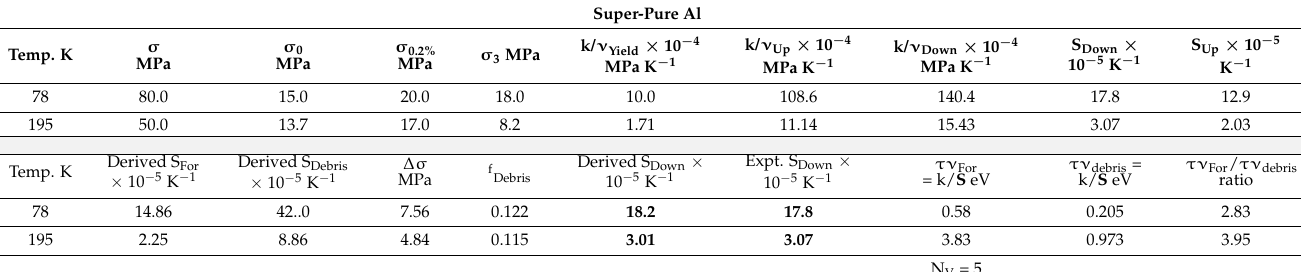
Table 1. Parameters to characterize linearized Haasen plot for super-pure Al and